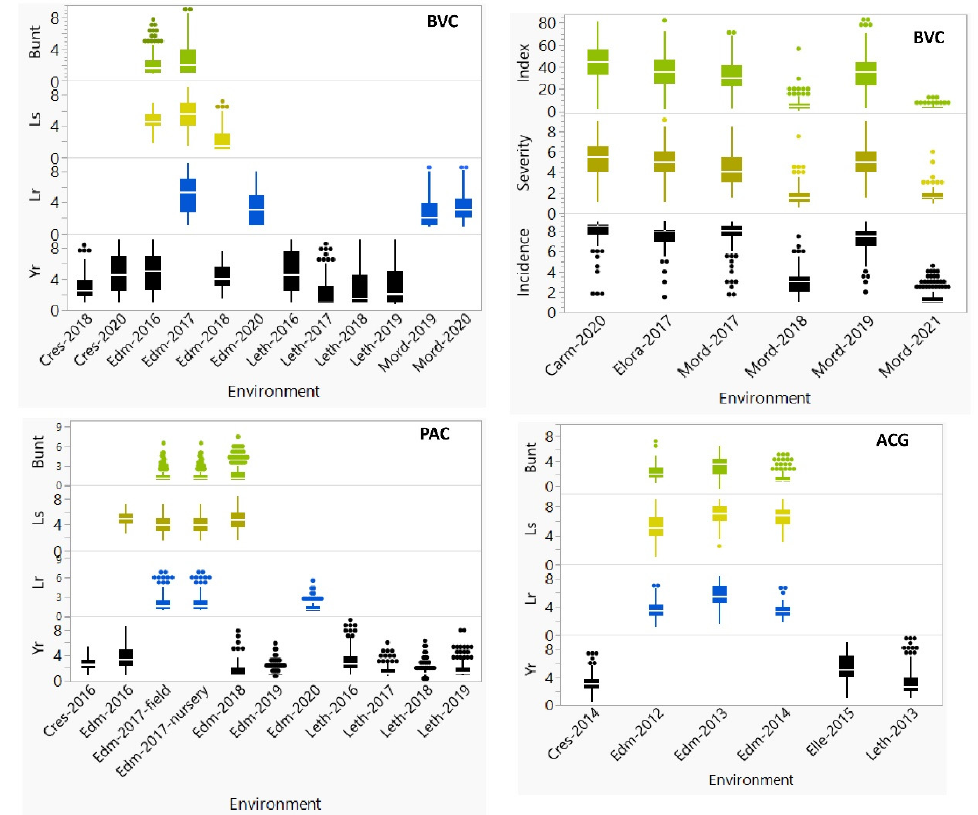
Figure 1. Box plots of the best linear unbiased estimators (BLUEs) of Fusarium head blight (FHB), stripe rust (Yr), leaf rust (Lr), leaf spot (Ls), and common bunt (bunt) in three spring wheat populations evaluated in field conditions. All diseases were rated on a 1 to 9 scale, except the FHB index in percentage. Both ACG and PAC are recombinant inbred lines derived from Attila × CDC Go and Peace × Carberry, respectively, whereas BVC is an association mapping panel of diverse spring wheat cultivars and lines. The environments on the x -axis start with a prefix for each site (Cres: Creston station in British Columbia; Edm: the University of Alberta South Campus in Edmonton; Elle: